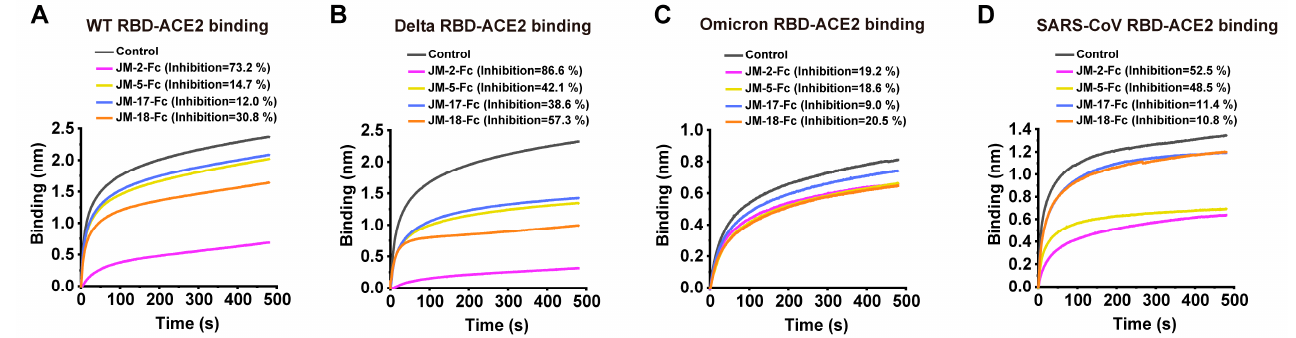
Figure 4. RBD-ACE2 blocking activities of isolated VNARs characterized by BLI assay. ( A – D ) Blocking of ACE2 binding to RBD of WT ( A ), Delta ( B ), Omicron ( C ), and SARS-CoV ( D ) by VNARs. Biotinylated RBD was loaded on SA biosensors to a load threshold above 1.0 nm, then incubated with VNAR-Fc fusion and ACE2 sequentially. VNAR was replaced with PBST and used as a control. The inhibition rates of VNARs were calculated against the control group.